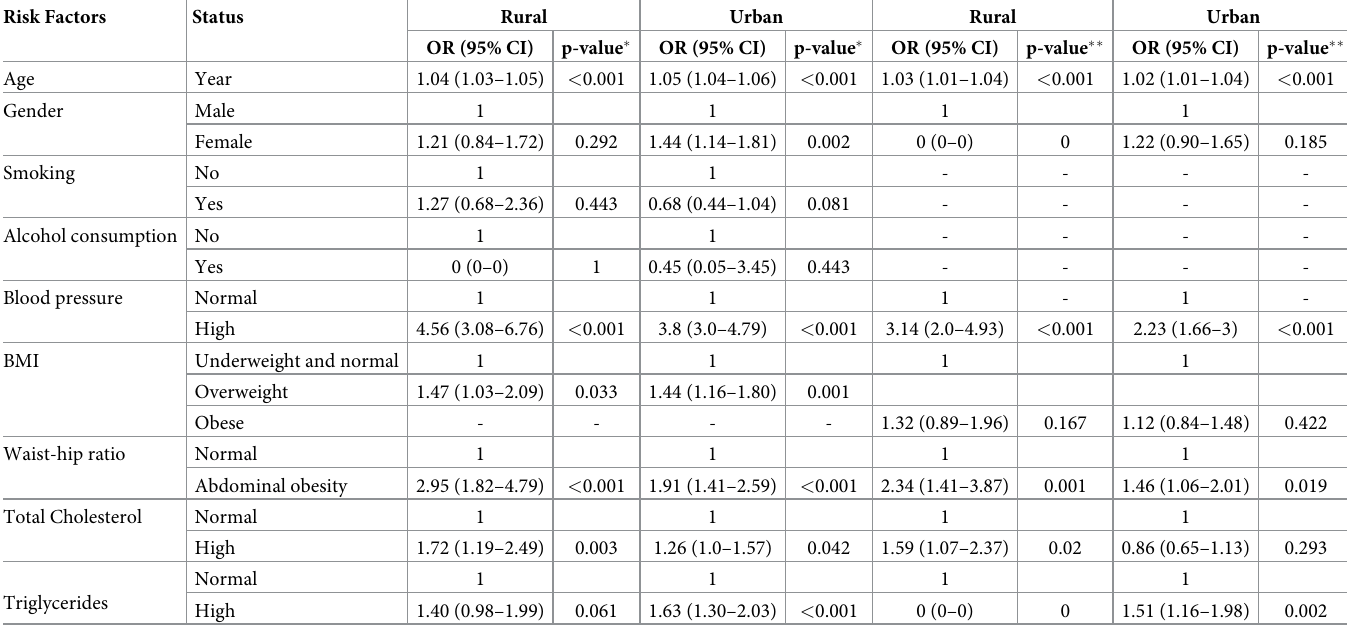
Table 4. The odds ratio of risk factors for developing T2DM by